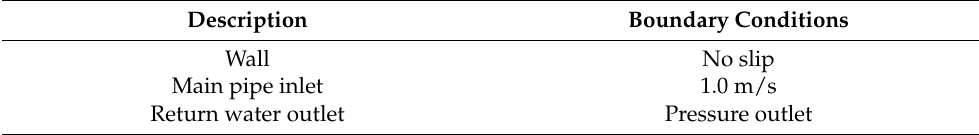
Table 1. Boundary conditions for two-phase water diffuser